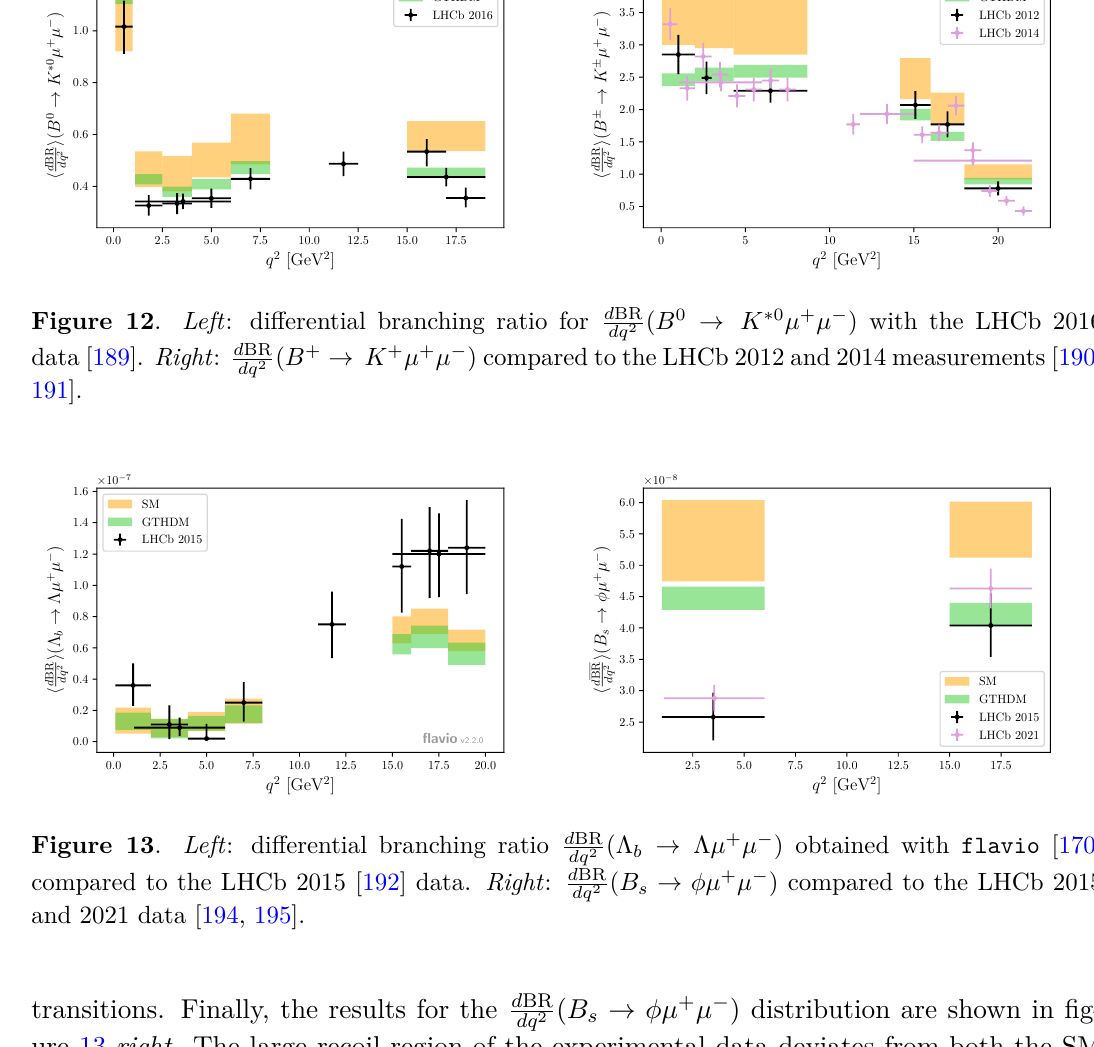
Figure 13 . Left : differential branching ratio d BR compared to the LHCb 2015 [192] data. Right : d BR and 2021 data [194,